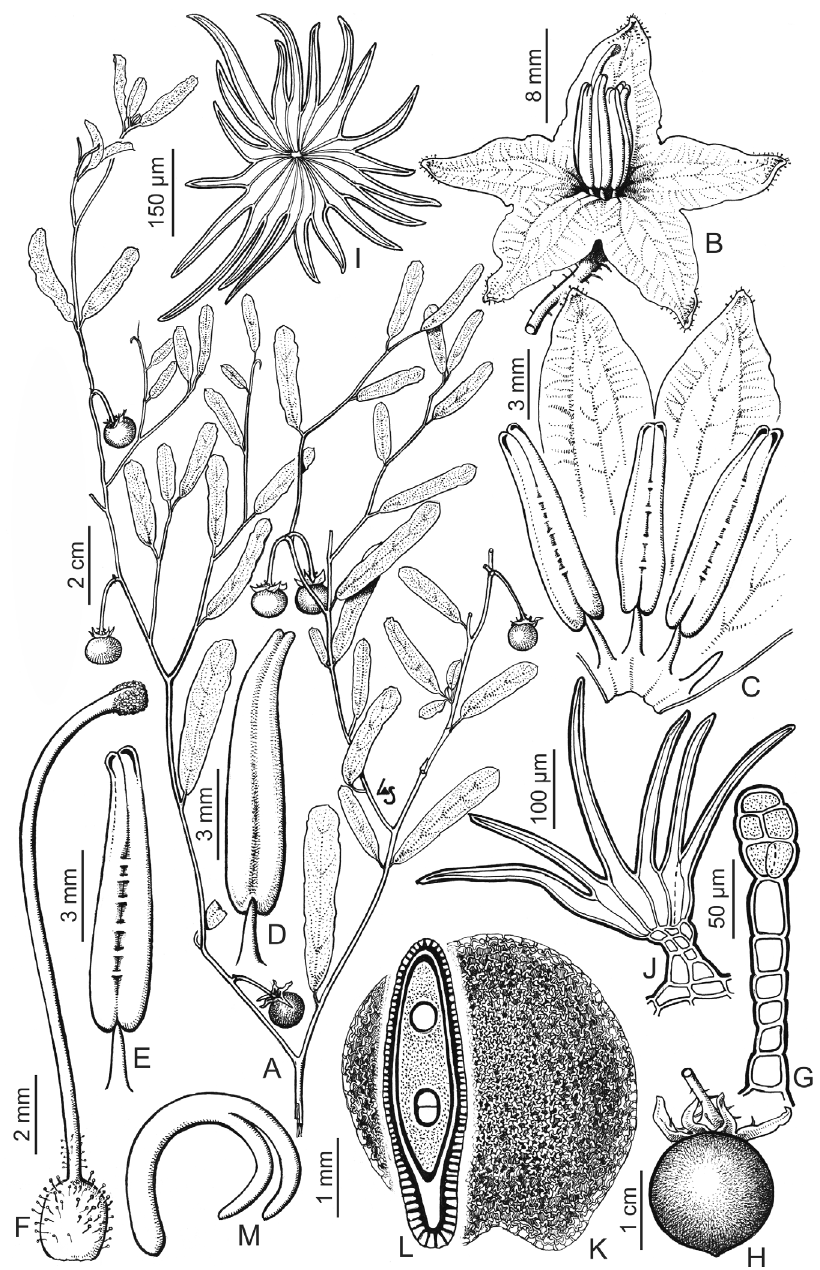
Figure 5. Solanum elaeagnifolium Cav. A Fruiting branch B Flower C Spread corolla D Dorsal view of stamen E Ventral view of stamen F Gynoecium G Glandular trichome from gynoecium H Fruit I Lepi- dote trichome from calyx, seen from above J Lepidote trichome from calyx, seen from the side K Seed L Transverse section of seed M Embryo. Drawn by Leonor Sánchez. Reproduced with permission from Flora Argentina (Chiarini